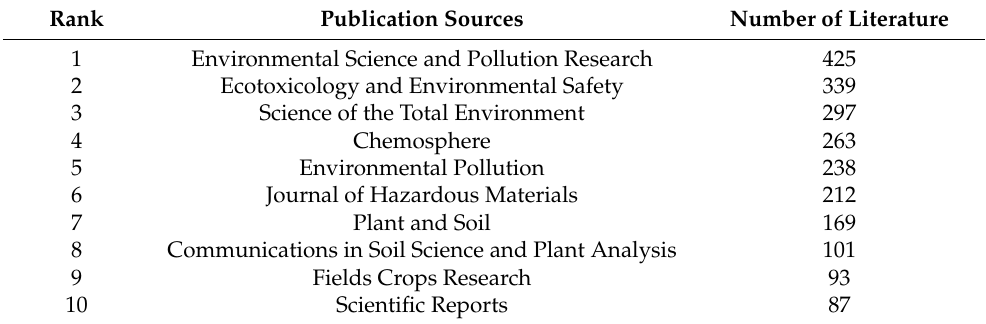
Table 3. Analysis of the publication sources for studies on cadmium pollution in rice and wheat cropping system from 2000 to